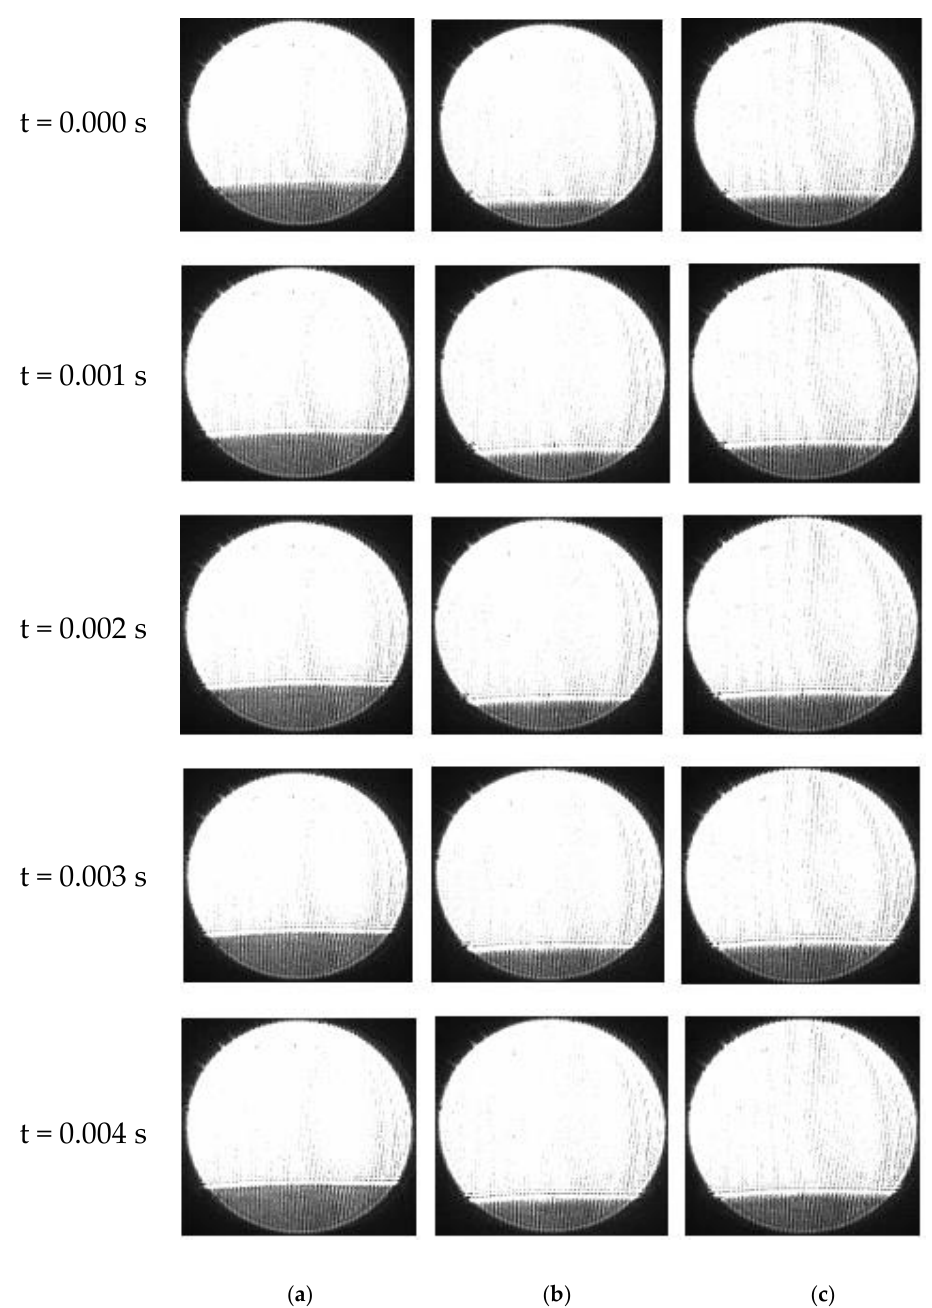
Figure 4. Temporal variations of interferogram with nickel sheet (infinite fringe, δ = 0.0075 mm). ( a ) 17 V, ( b ) 19 V, ( c ) 21 V.